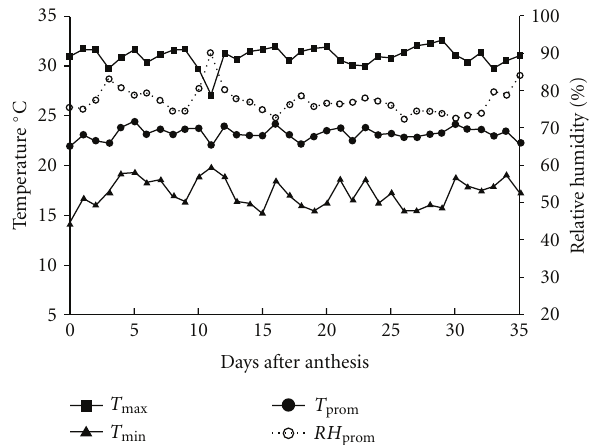
Figure 4: Registered temperature and relative humidity during grain filling of rice Morelos A-98 (registered data from September 17 to October 21, 2007).